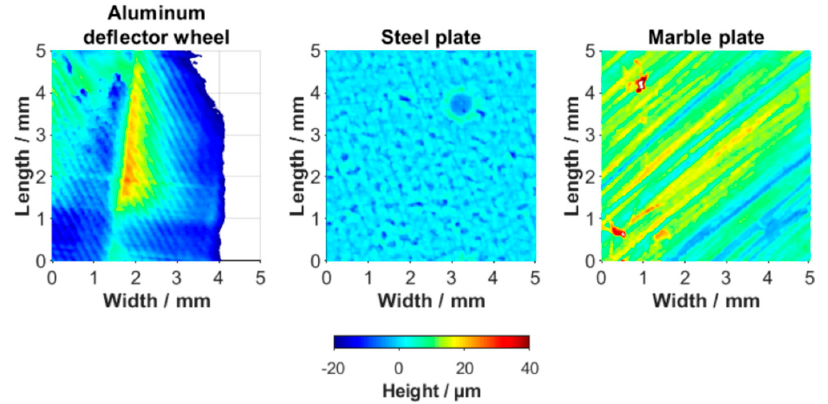
Figure A3. Surface height profile of the used impaction plates, measured with a white light interfer- ometer (Sensor: WLI PL, FRT GmbH).